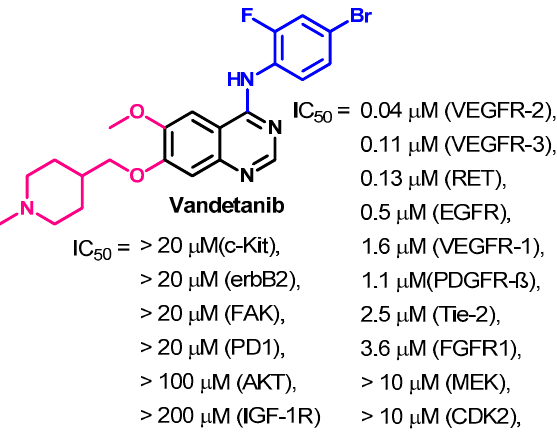
Figure 64. Two/three-dimensional binding mode of vandetanib (ZD6, pdb: 2IVU) bound to the phosphorylated RET tyro- sine kinase domain: ( A ) 3D binding mode, receptor shown as hydrogen bond surface; ( B ) 2D binding mode of vandetanib showing different types of interaction with amino acids in RET; the figure was generated using Discovery Studio Visual- izer (V16.1.0.15350).